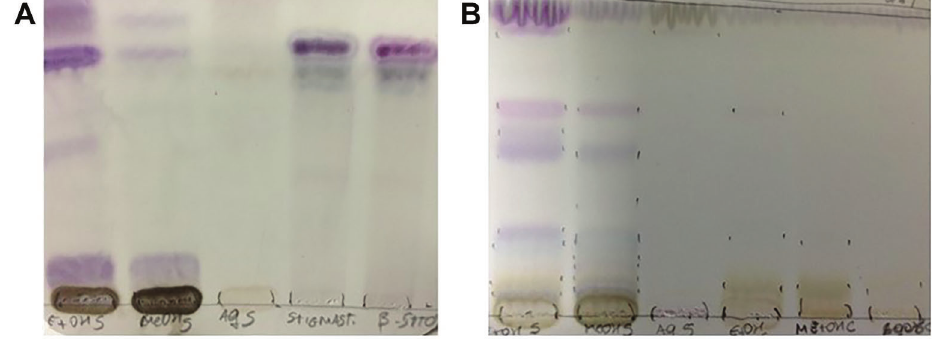
Figure 1. Thin layer chromatography of the melon seed ( A ) and peel ( B ) extracts with stigmasterol and b -sitosterol standards. AcOET: MetOH 5:5:0.5. AcOET: Formic acid: water: MetOH